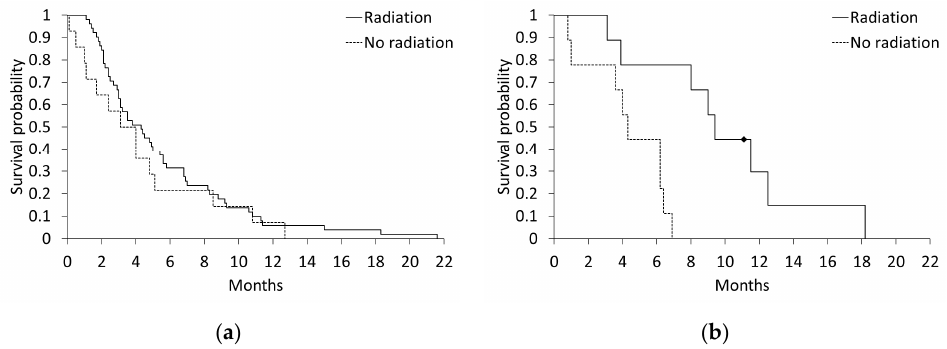
Figure 1. Survival curves for the arms with and without radiation during surgery: ( a ) pancreatic head subgroup; ( b ) “other” subgroup. Table 1. Restricted mean survival times (RMSTs) for the arms with and without radiation, for the pancreatic head and “other” subgroups, and the RMST differences between the two arms.